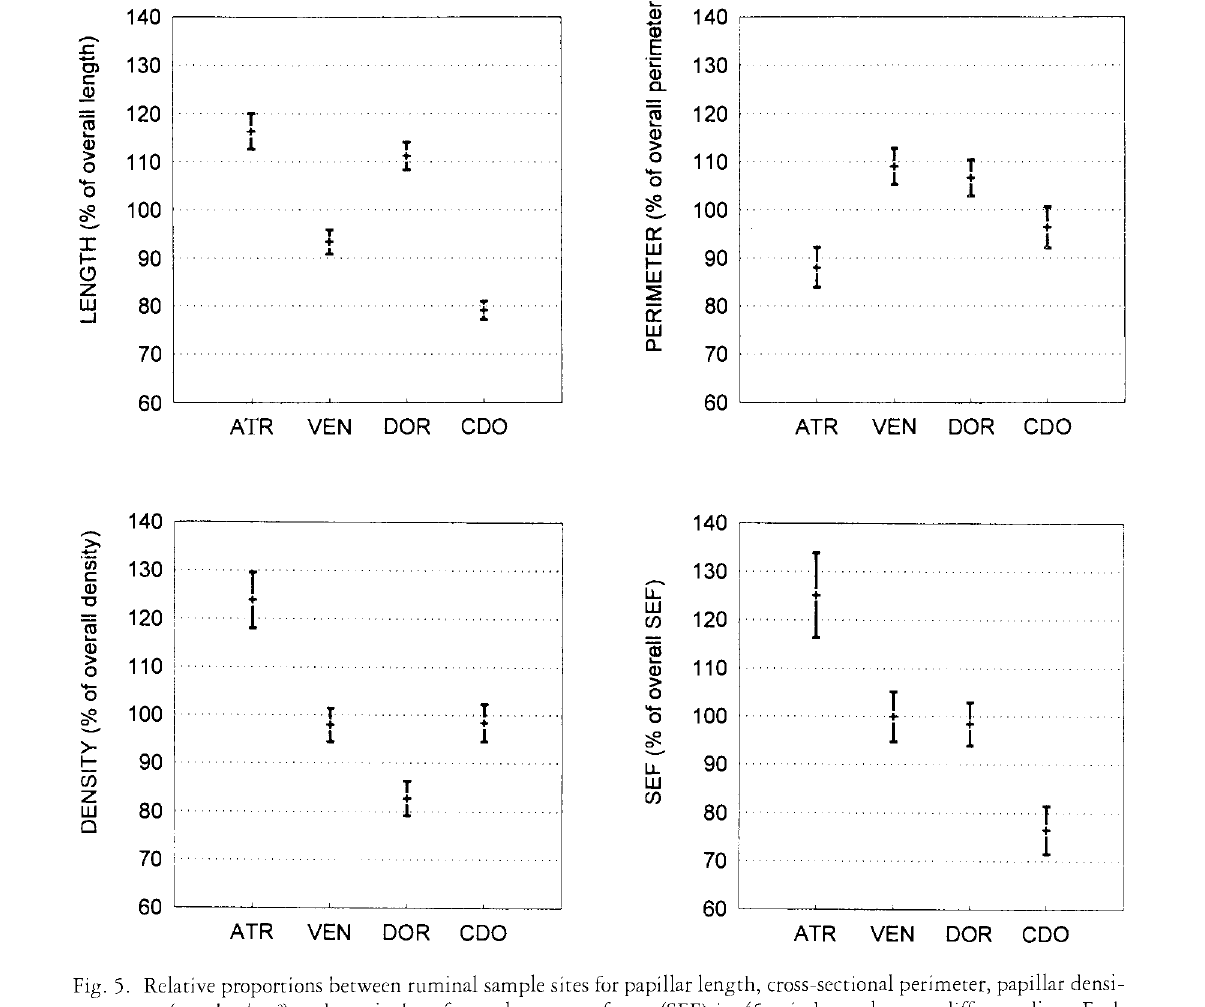
Fig. 5. Relative proportions between ruminal sample sites for papillar length, cross-sectional perimeter, papillar densi ty (number/cm 2 ) and ruminal surface enlargement factor (SEF) in 45 reindeer calves on different diets. Each sample site is expressed as percentage of the mean of all four sample sires (the "overall" value). Figure shows mean percentage for each sample site (n = 45) and 95% confidence limits of the mean. ATR = atrium ruminis, VEN = ventral rumen, DOR = dorsal rumen, CDO = caudodorsal blind sac. respectively), but not in VEN and DOR.